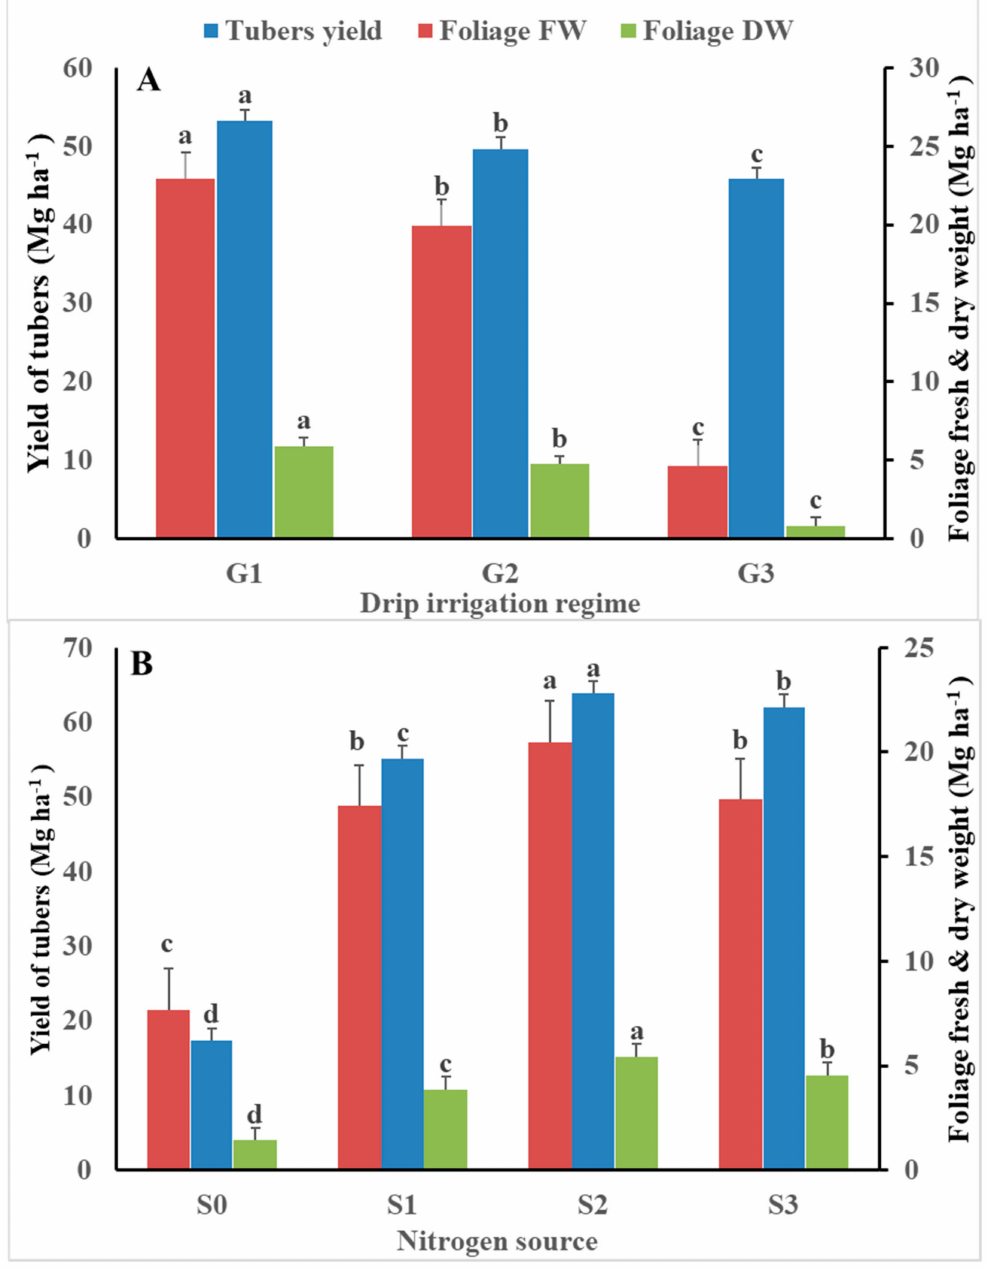
Figure 3. Average e ff ect of drip irrigation regime ( A ) and N source ( B ) on tubers and foliage yields of potato (Mg ha − 1 ). FW = fresh weight; DW = dry weight; G 1 = 120% ETc irrigation; G 2 = 100% ETc irrigation; G 3 = 80% ETc irrigation; S 0 = Unfertilized (control); S 1 = Urea; S 2 = Ammonium nitrate; S 3 = Ammonium sulfate; values for the same parameter without a common letter are significantly di ff ered ( P >